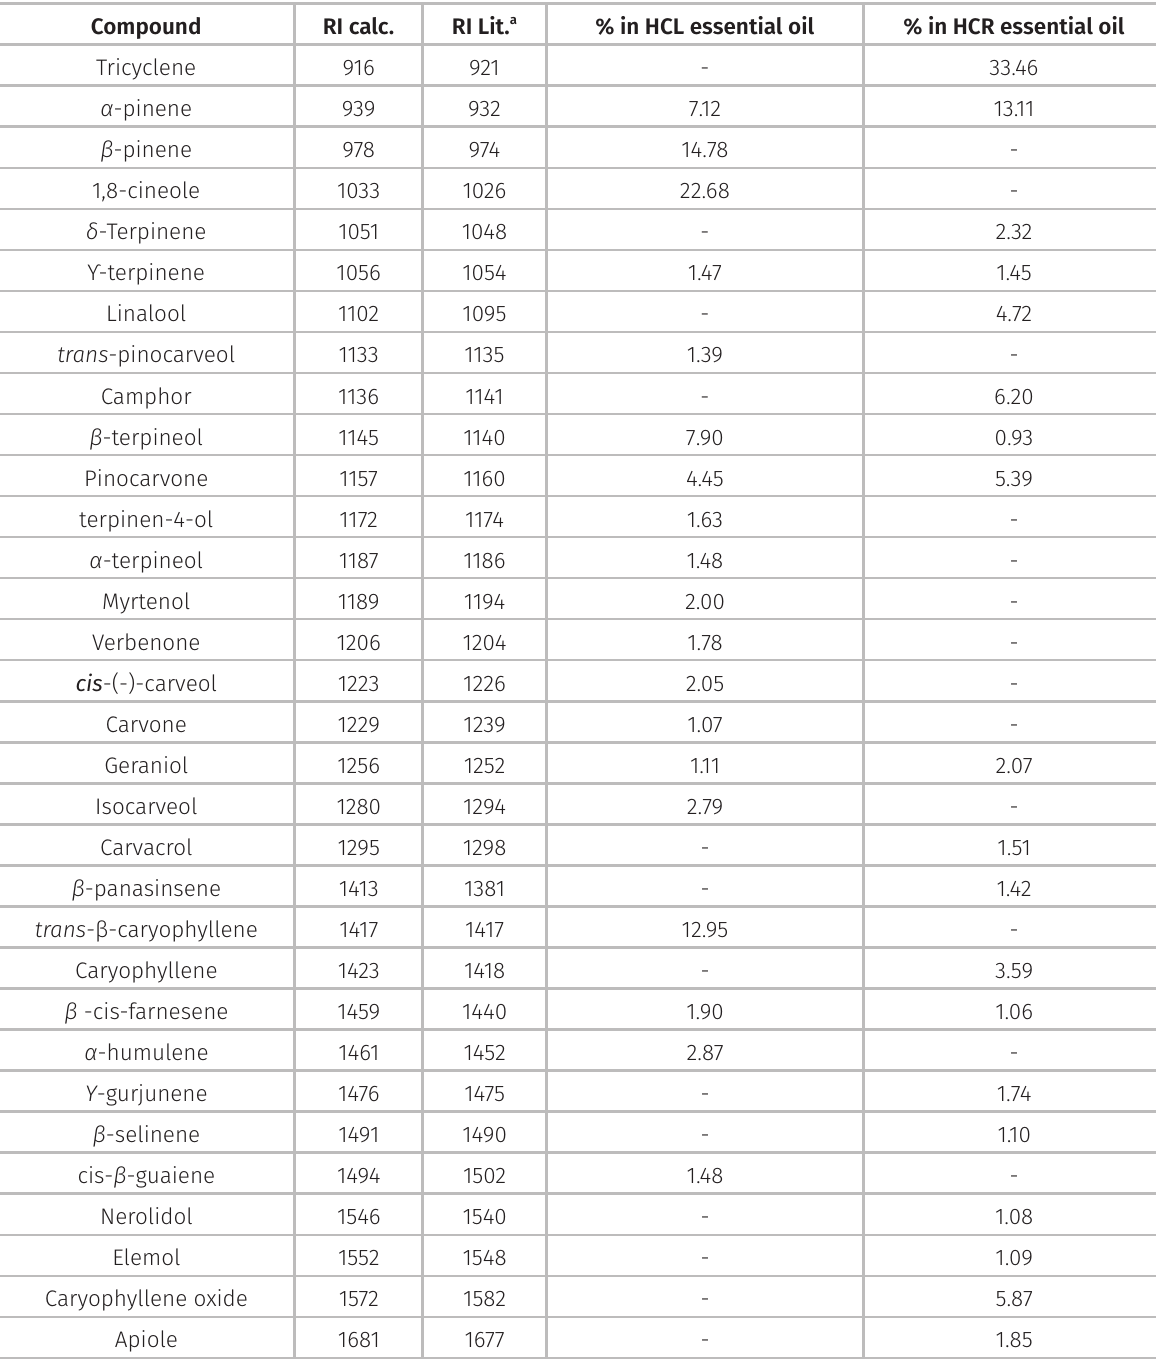
Table I. Chemical constituents of EOs of Hedychium coronarium J. Koening leaves (HCL) and rhizomes (HCR). aretention index (RI) calculated relative to a series of